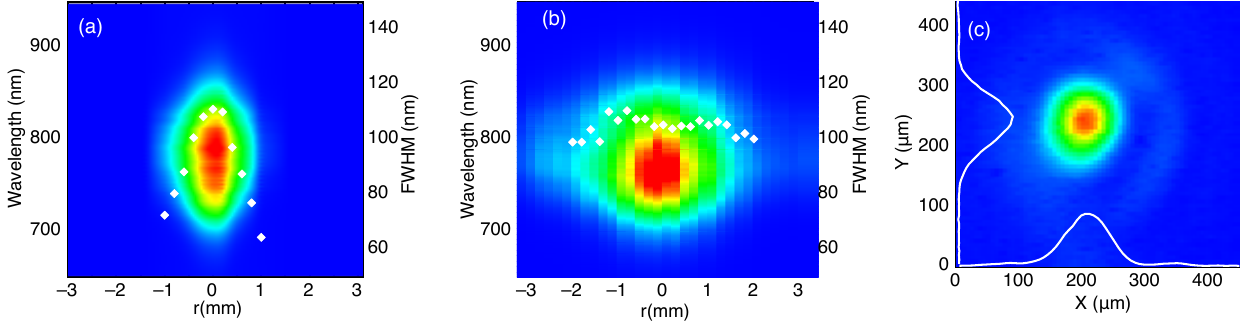
Figure 4. Spectro-spatial distribution of the XPW beam, 15 cm after the second crystal ( a ) and propagated over 2 m ( b ). Spectral FWHM measured across the beam profile are indicated with white diamonds; ( c ) Spatial intensity distribution of the XPW beam at the focus of a 500 mm